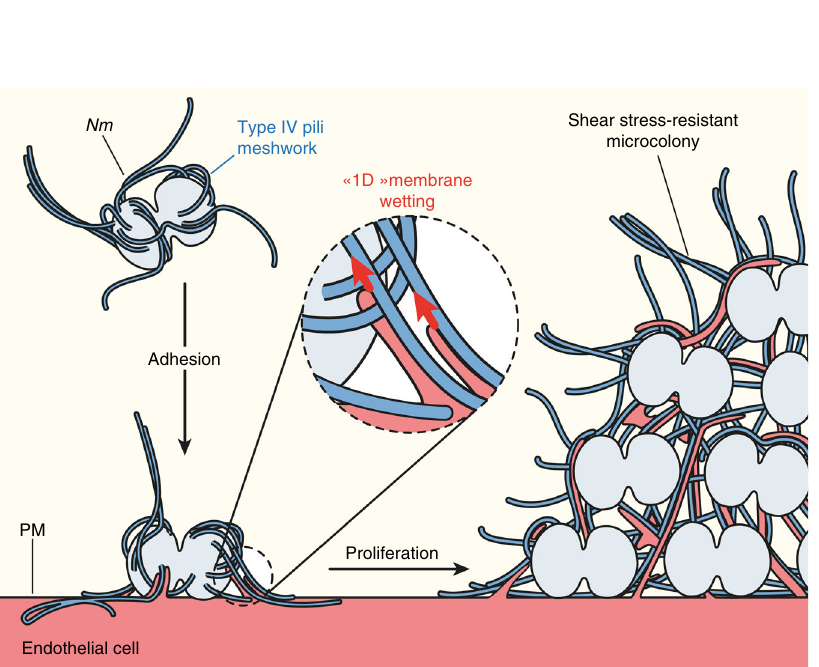
Fig. 5 Working model for the mechanism of wetting-induced plasma membrane protrusions by Nm T4P fi bers. Nm produces T4P as a meshwork of fi bers. Upon adhesion to the host endothelial cell, the high adhesiveness of T4P allows “ 1D ” membrane wetting of the plasma membrane, and thus remodeling of the membrane alongside T4P fi bers. As the bacteria proliferate and aggregate extracellularly, plasma membrane protrusions remain attached to T4P fi bers and end up embedded in a dense extracellular T4P meshwork. This complex T4P-plasma membrane structure provides the microcolony with enough